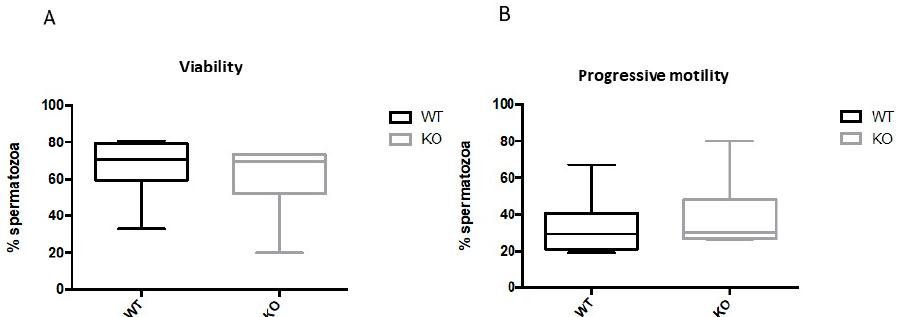
Figure 3. Viability and progressive motility of spermatozoa was comparable in WT and KO mice. The box plots report the evaluation of viability ( A ) and progressive motility ( B ) for spermatozoa collected from WT and KO mice. Both viability and progressive motility were not significantly changed ( p > 0.05) by KO of Kir5.1